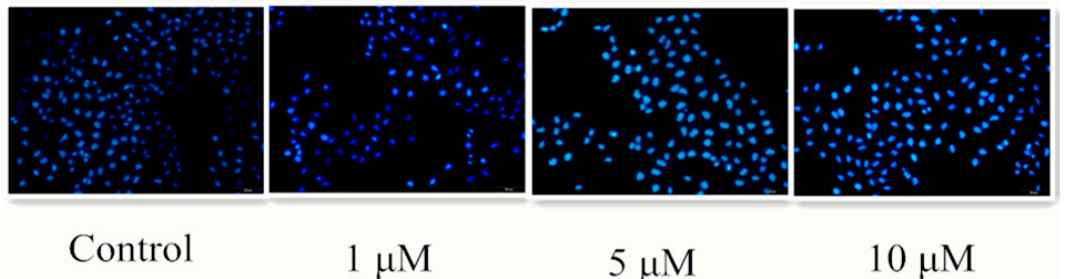
Figure 3. Effect of compound 4j on the nuclear morphological changes of MGC-803 cells. Images were acquired using an OLYMPUS 1X73 fluorescence microscope (magnification 200×).